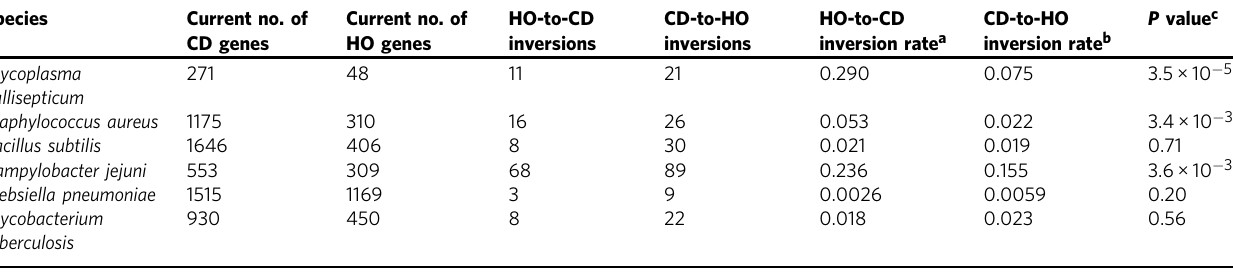
Table 3 HO-to-CD and CD-to-HO inversion rates based on the inversions inferred by the phylogeny-based standard method.